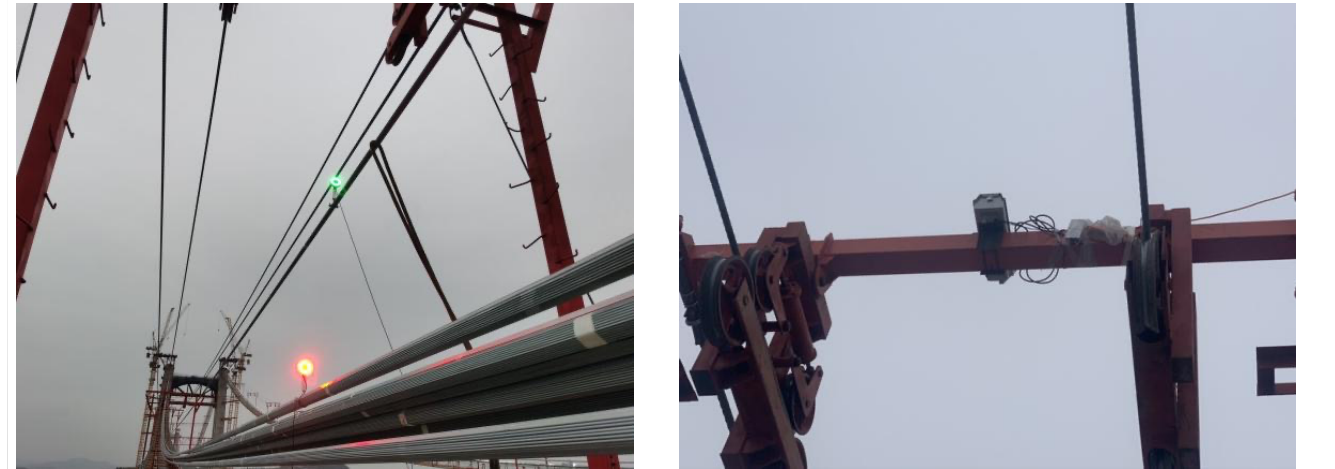
Figure 18. Photos of on-site installation of the optical targets and the camera. Table 4. Specifications of the main hardware.